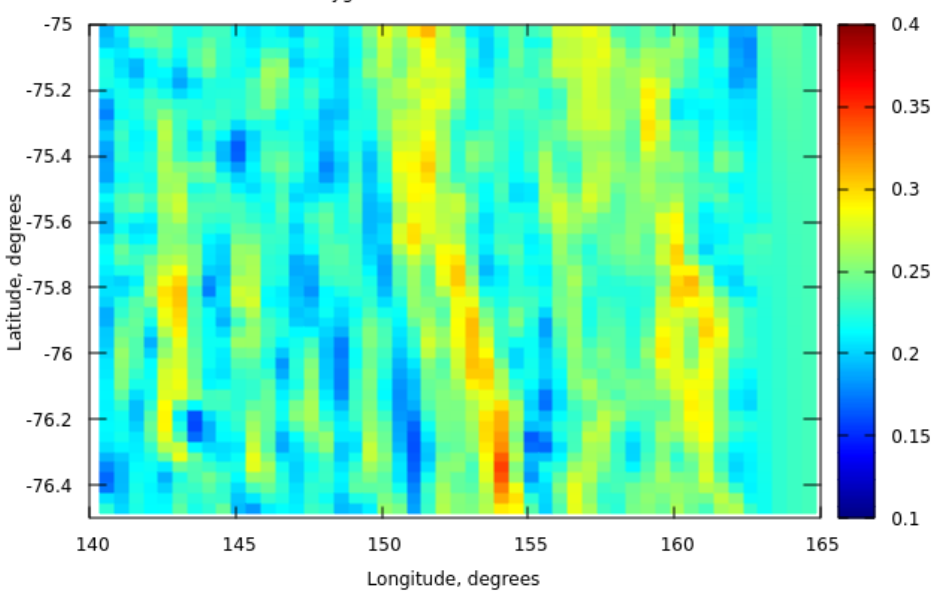
Figure 9. OLCI reflectance at 761.25 nm for the case shown in Figure 8. The histogram of the coefficient of variance corresponding to the data shown in Figure 8 is given in Figure 10. We see that the values of CV are smaller than 10% for most cases. There are regions in Eastern Antarctica, where the deviations are below 5%. The areas with larger deviations could be due to the presence of clouds or structures on the snow surface not captured by the proposed model. The differences can be further decreased if OLCI gains are used as discussed